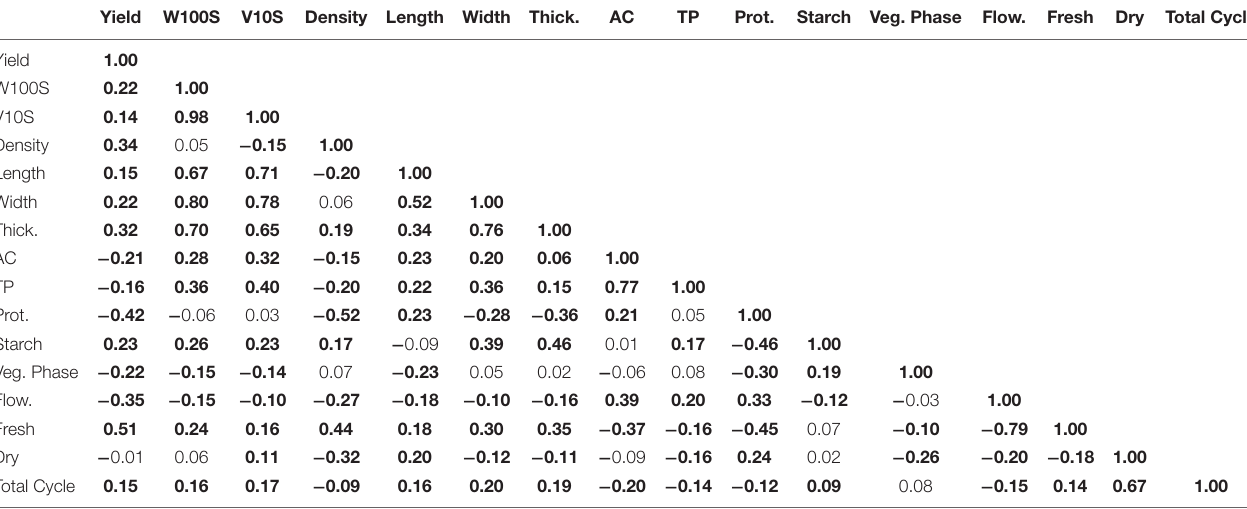
TABLE 9 | Correlation coefficients of the variables accessed in this study for climbing accessions, estimated by the REML (Restricted Maximum Likelihood) method. Yield W100S V10S Density Length Width Thick.